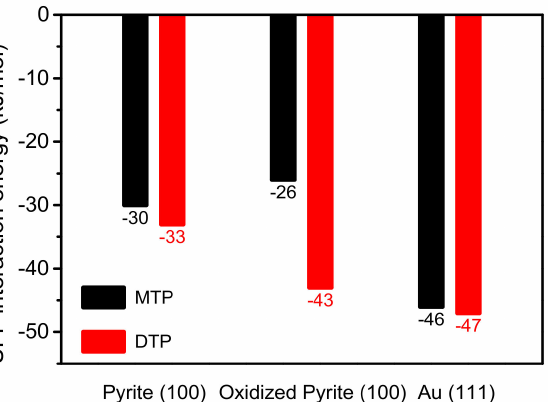
Figure 7. UFF interaction energy of MTP and DTP on Au (111), pyrite (100) and oxidized pyrite